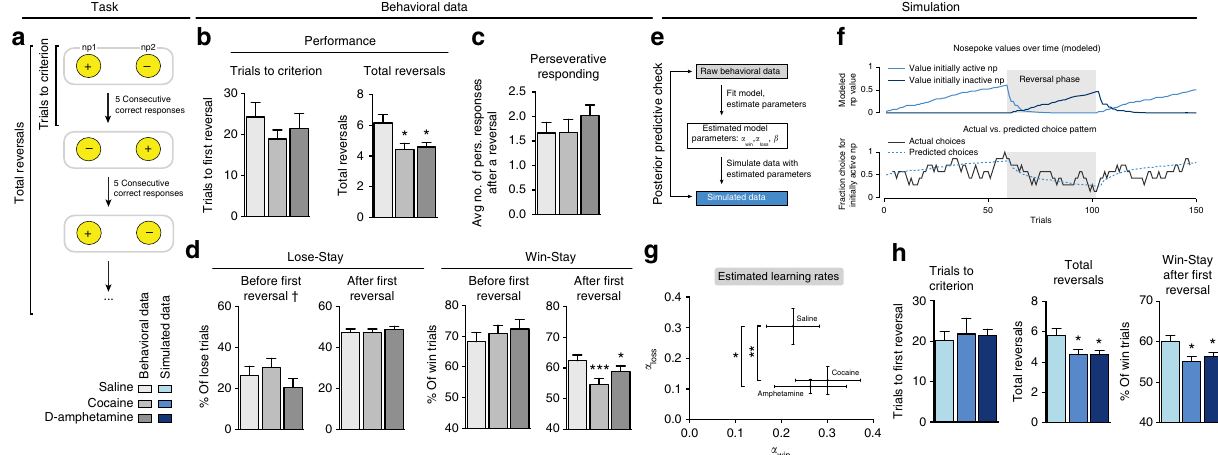
Fig. 1 Treatment with cocaine or D-amphetamine impairs reversal learning. a Task design. b Systemic cocaine (10 mg/kg) or D-amphetamine (0.25 mg/ kg) treatment did not alter the number of trials required to reach fi rst reversal (one-way RM ANOVA, p = 0.55), but decreased the total number of reversals accomplished (ANOVA, p = 0.0037; post-hoc test versus saline, p = 0.0102 cocaine, p = 0.0197 D-amphetamine). c Treatment with cocaine or D-amphetamine did not alter perseverative behavior after a reversal ( p = 0.46). d Lose-stay behavior was unaffected after cocaine or D-amphetamine treatment, both before ( p = 0.21 † ) and after ( p = 0.77) the fi rst reversal. Cocaine and D-amphetamine decreased win-stay behavior after (ANOVA, p = 0.0007; post-hoc test versus saline, p = 0.0009 for cocaine, p = 0.0336, D-amphetamine), but not before the fi rst reversal ( p = 0.67). Repeated measures from n = 25 animals. † Six animals had no losses before the fi rst reversal, so the ANOVA was performed on data of n = 19 animals; graph shows n = 25. e We used a modi fi ed Rescorla – Wagner model to describe the behavior of the rats during reversal learning. f Example session. (Top) Simulated values of the nose pokes, given the rat ’ s optimal model parameters and observed choices. (Bottom) Modeled choice probabilities, converted from the simulated nose poke values using a softmax (unsmoothed), and the rat ’ s actual choice pattern (smoothed over 7 trials). g Best- fi t learning parameters. Treatment with cocaine and D-amphetamine decreased α loss , without affecting the other model coef fi cients (Wilcoxon matched-pairs signed rank test, * p = 0.032, ** p = 0.0046, see Supplementary Table 2). h Simulating data with the model parameters extracted in g replicated the drug-induced effects of the behavioral data ( n = 25 simulated rats; ANOVA trials to criterion, p = 0.86; total reversals, p = 0.0114, post-hoc test, p = 0.0411 for cocaine, and p = 0.0215 for D- amphetamine; ANOVA win-stay, p = 0.0090, post-hoc test, p = 0.0181 for cocaine and p = 0.0462 for D-amphetamine. ANOVA on all other measures, p > 0.1). Data shown as mean ± standard error of the mean; * p < 0.05, ** p < 0.01, *** p <